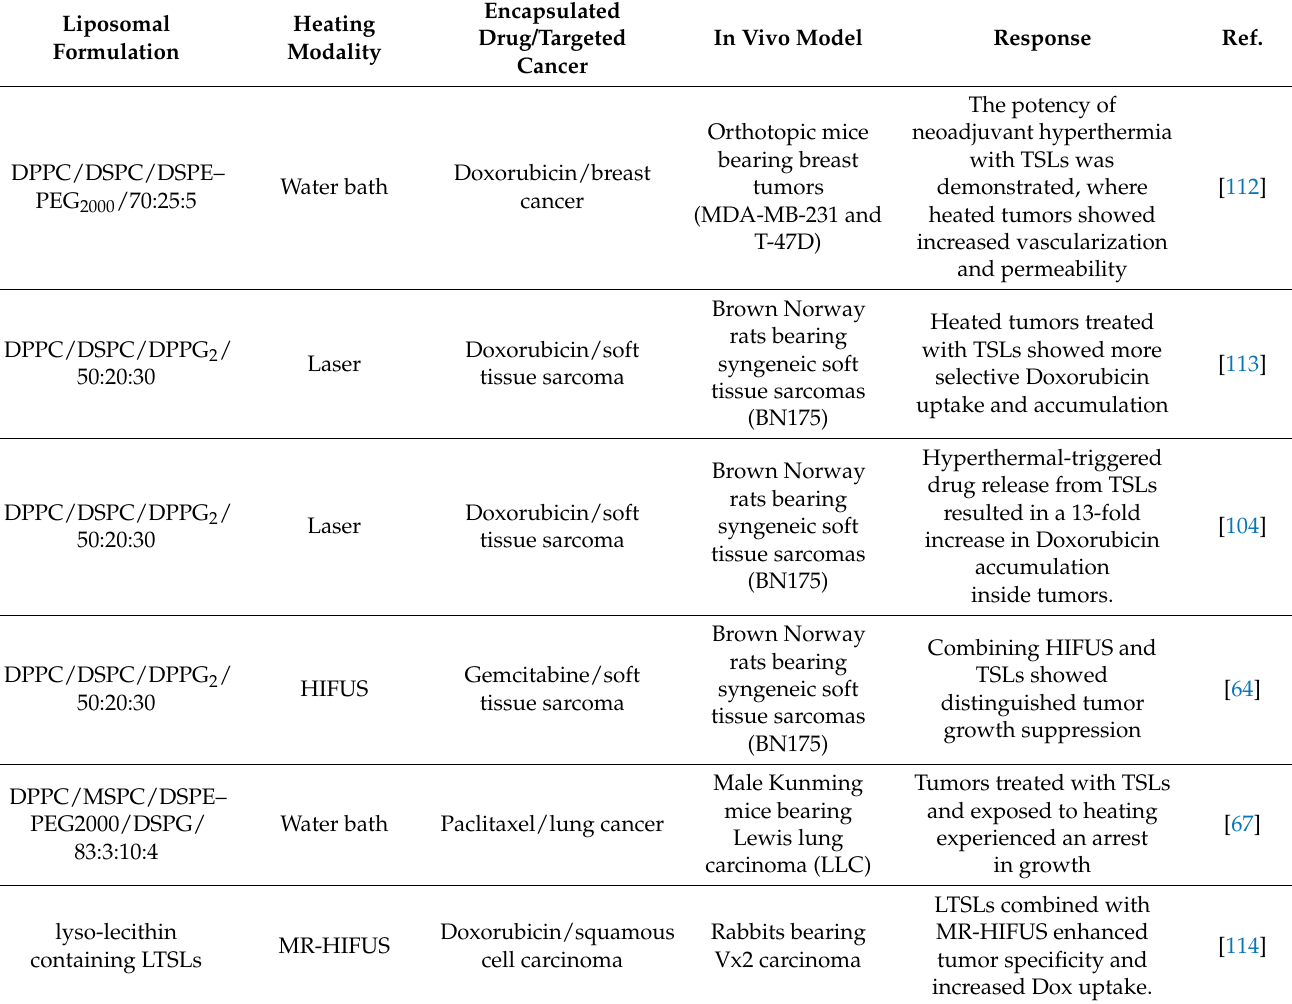
Table 5. Summary of various studies using different heating modalities to trigger release from